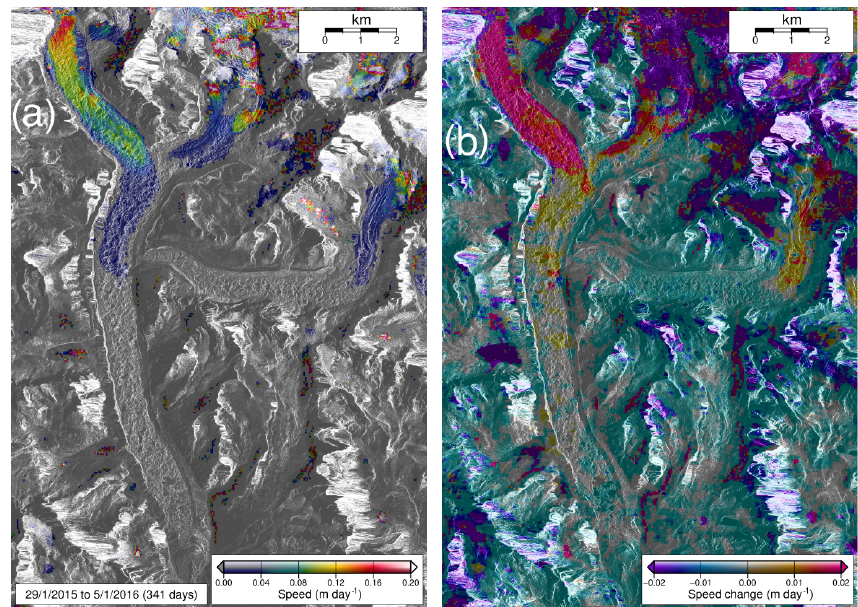
Figure 8. Surface velocities derived from TerraSAR-X data: (a) mean daily velocity for the “annual” period (29 January 2015 to 5 January 2016); (b) velocity difference between “annual” period (29 January 2015 to 5 January 2016) and “winter” period (19 September 2014 to 18 January 2015), indicating minimum summer speed-up of the glacier. No masks or filters were applied to the